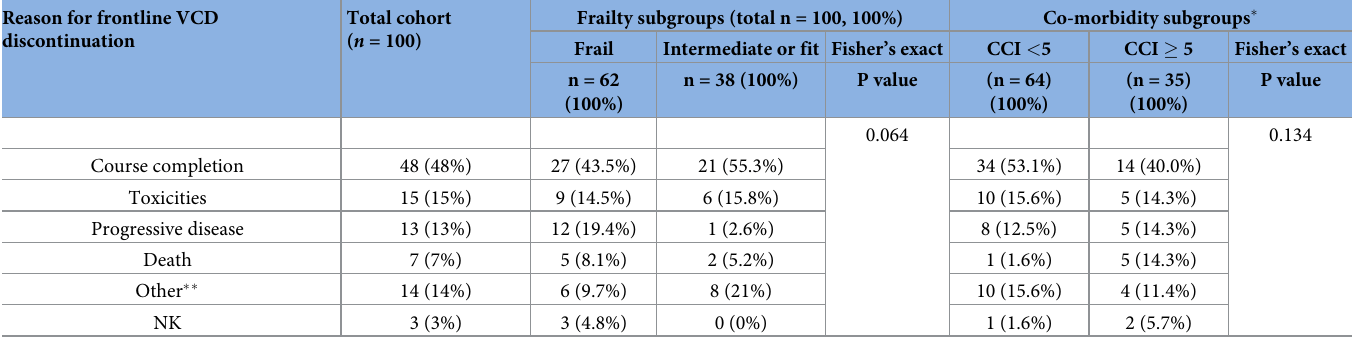
Table 2. Reasons for discontinuation of first line VCD myeloma therapy in the total cohort, in MRP subgroups (frail vs. intermediate or fit) and in co-morbidity subgroups. Reason for frontline VCD discontinuation